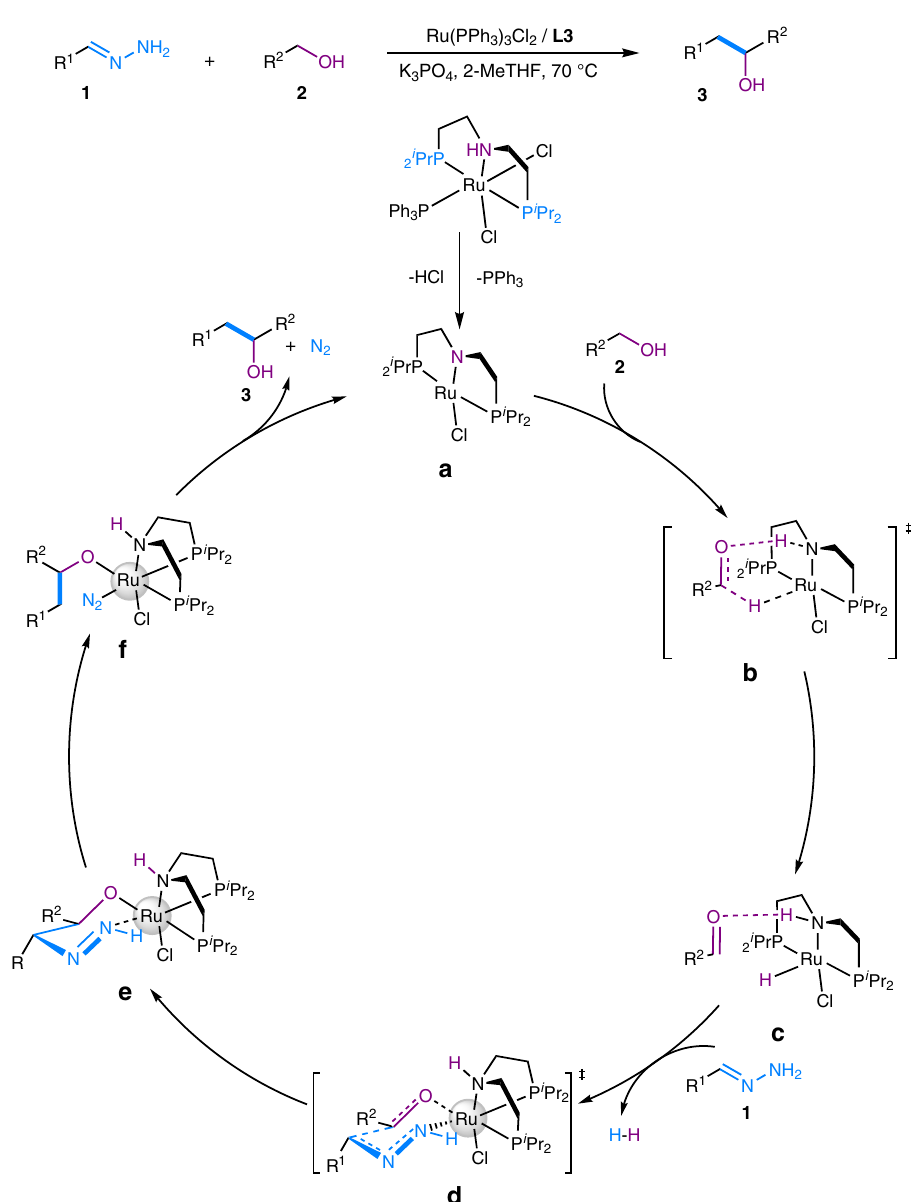
Fig. 5 Proposed mechanism for the alcohol-surrogated Grignard-type reaction. The proposed mechanism starts from the tetracoordinated ruthenium complex. Both the dehydrogenation step and a C – C bond formation step experience six-membered-ring transition states. Speci fi cally, a active species to start the catalytic cycle; b six-membered-ring transition state for dehydrogenation; c ruthenium-hydride species after the dehydrogenation step; d transition state for 1,2-addition of hydrazone to carbonyl; e intermediate right after C – C bond formation; f intermediate after denitrogen which then followed by the formation of desired